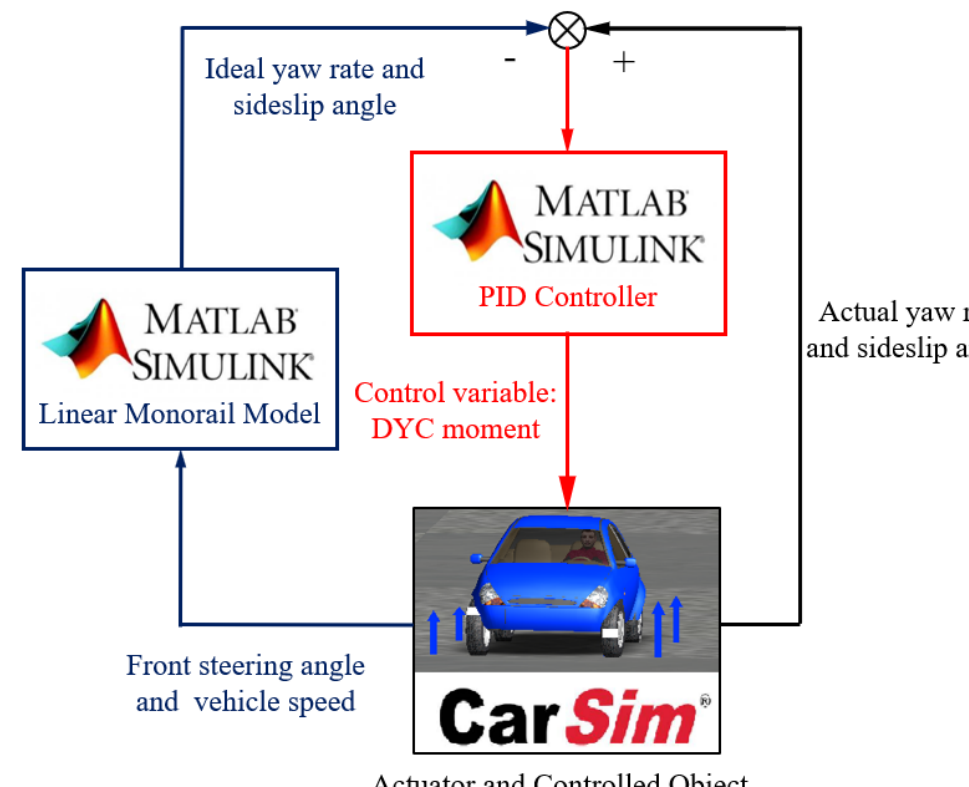
Figure 2. Proportional–integral–differential (PID) control principle.